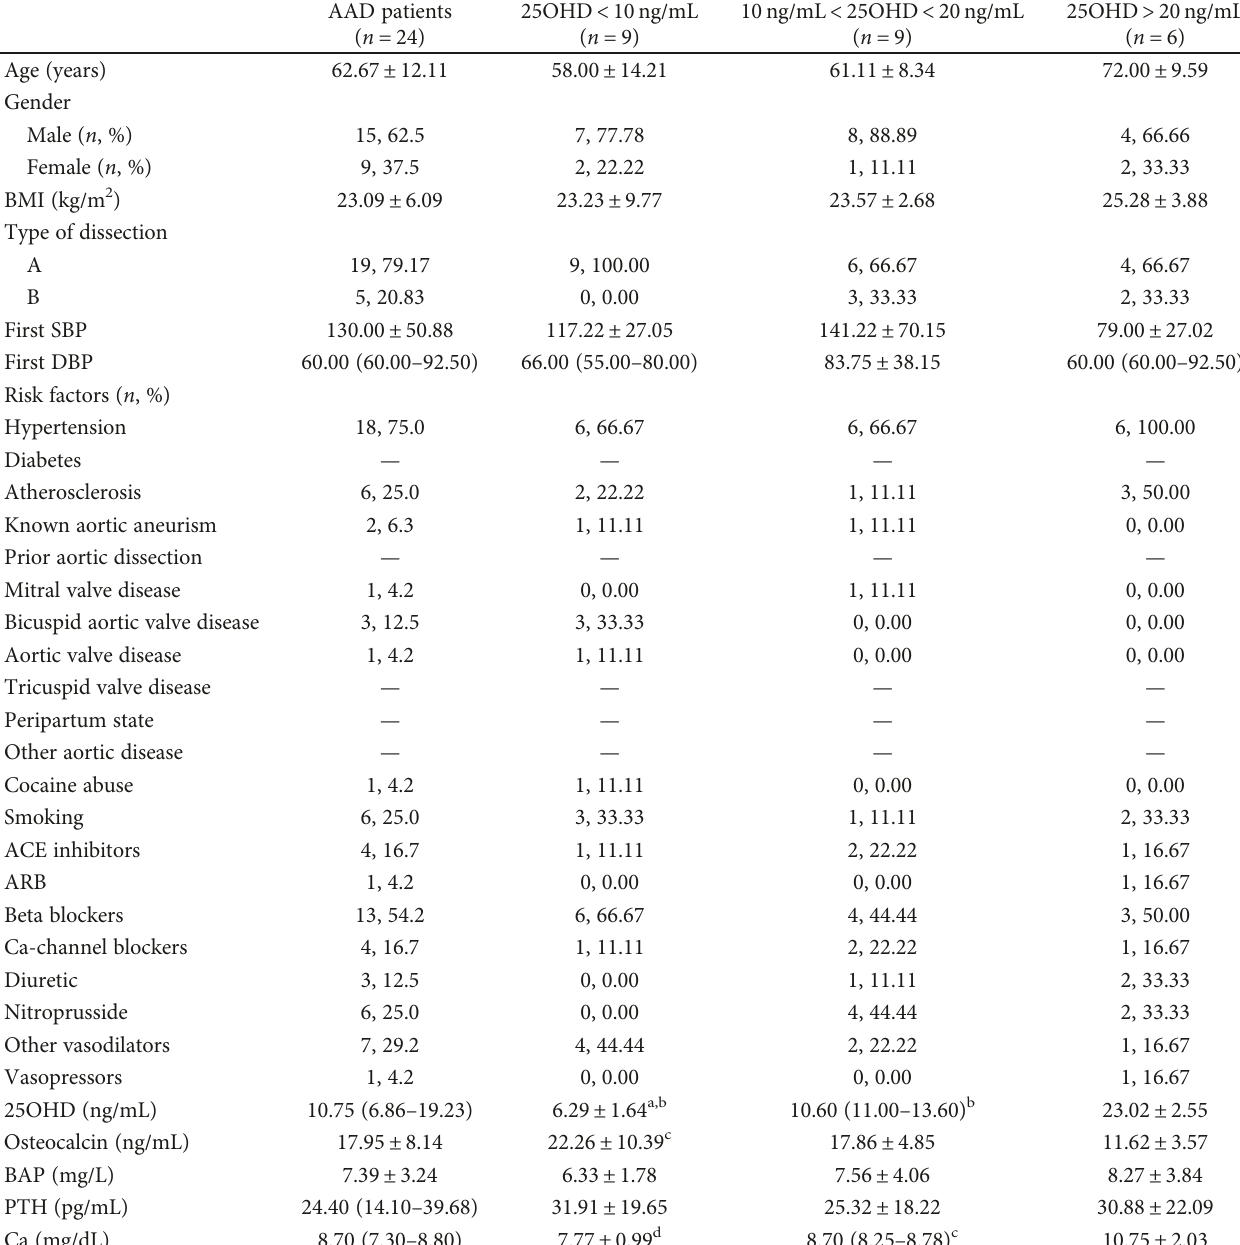
Table 1: Characteristics of participants included in the